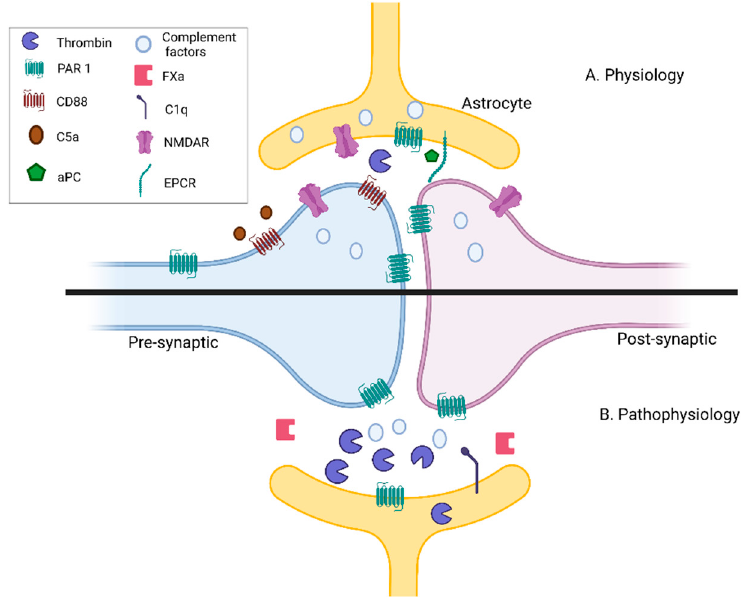
Figure 2. Complement and coagulation cascade neuroinflammatory effects on synapses: ( A ) During development, complement and coagulation components, which are localized to neurons, astrocytes, and glial cells, help mediate synapse elimination in critical pathways in the central nervous system (CNS). C1q increases neuronal survival and arborization as well. CD88, the C5a anaphylatoxin receptor, is expressed locally on presynaptic terminals of mossy fibers in the CA3 region of the adult rat hippocampus. Thrombin and protease-activated receptor 1 (PAR1) are key players in synaptic transmission and plasticity. PAR1 increases N-methyl-D-aspartate receptor (NMDAR) currents, thereby modulating synaptic function. Activated protein C (aPC), endothelial cell protein C receptor (EPCR). ( B ) During pathophysiological states, complement and coagulation components are upregulated and have detrimental effects on synaptic transmission and plasticity. Reactive astrocytes express C1q, as well as other complement proteins, which may affect synaptic loss in the adult CNS. Following neuroinflammation, the thrombin pathway impacts synaptic function in neurological diseases such as AD, MS, diabetes, cerebral ischemia, and stroke. Illustration created with BioRender.com. Accessed date: 16 December